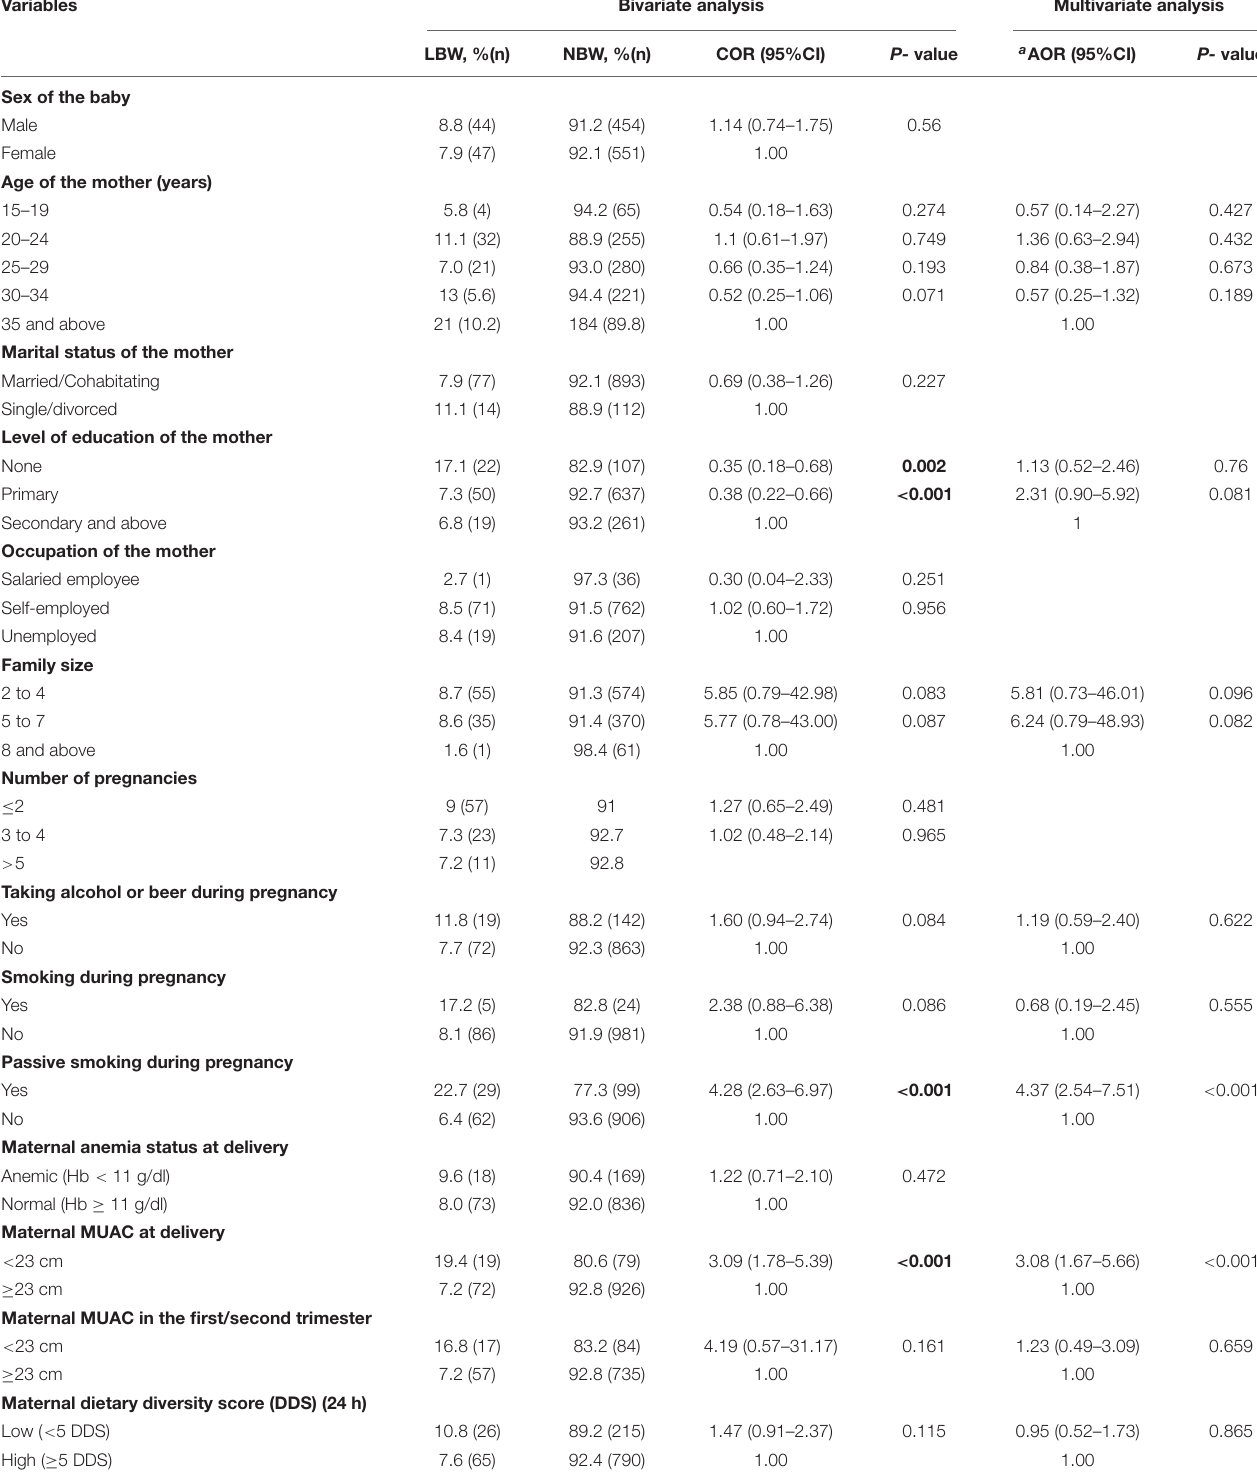
TABLE 3 | Bivariate and multivariate analysis: Socio-demography, obstetric, lifestyle, and nutritional status associated with LBW. Variables Bivariate analysis Multivariate